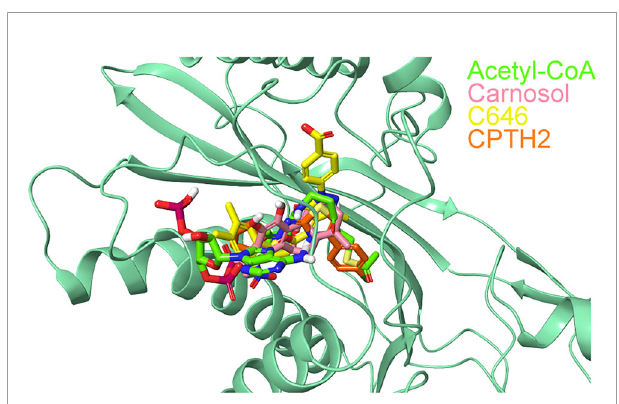
FIGURE 6 | Superposition of docked ligands in the active site of p300. The protein structure is shown in green cartoon representation, and the docked ligands — acetyl-CoA (green), carnosol (pink), C646 (yellow) and CPTH2 (orange) — are depicted in stick representation.